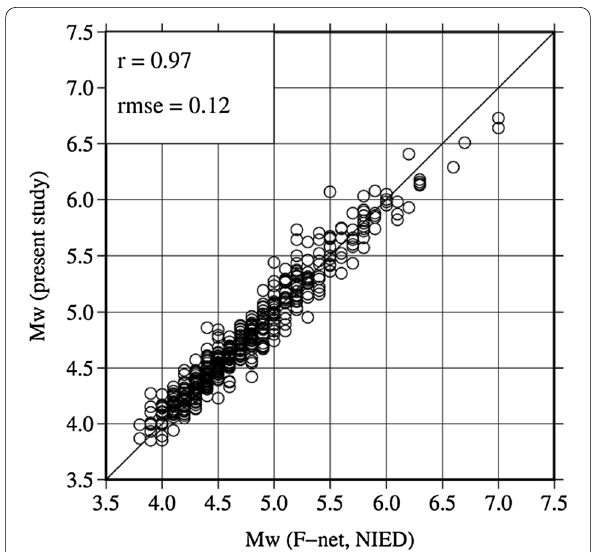
Fig. 5 Comparison between the F-net NIED catalog magnitudes and the magnitudes estimated from the source spectra. The correlation coefficient (r) and root mean square error (rmse) between the catalog and estimated magnitudes are indicated in the plot